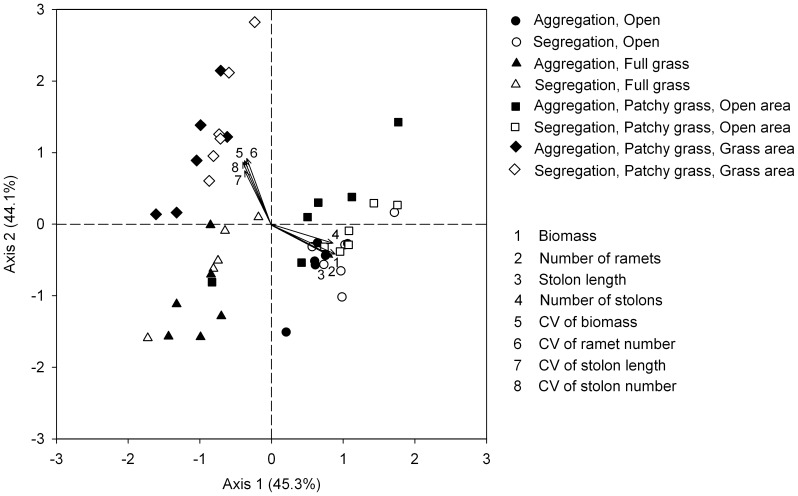
Scatter plot from Principal Component Analysis of the Hydrocotyle vulgaris populations at the patch level.Axis 1 and 2 explained 45.3% and 44.1% of the total variance, respectively. Response variable scores (arrows) are given.